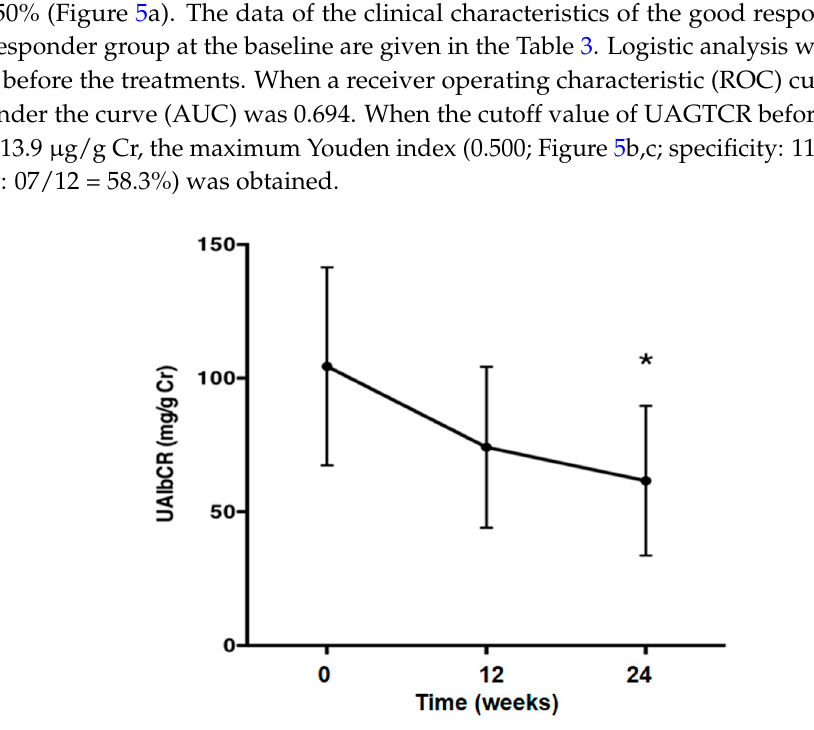
Figure 3. The urinary albumin/creatinine ratio was decreased after the treatment with olmesartan. One-way repeated measures ANOVA followed by Tukey’s multiple comparisons test were used to compare values over the time course. p < 0.05 was considered as statistically significant (* p < 0.05). UAlbCR, average urinary albumin/creatinine.